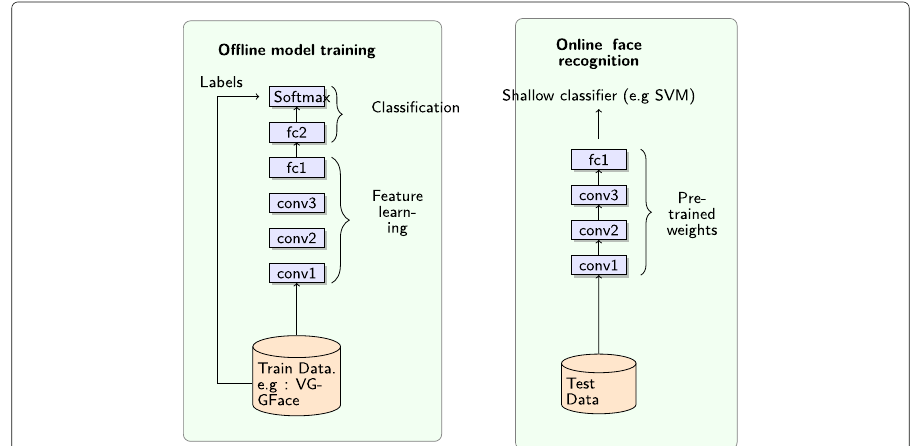
Fig. 6 Feature based transfer learning with pre-trained models. conv, convolution layer; fc, fully connected layer